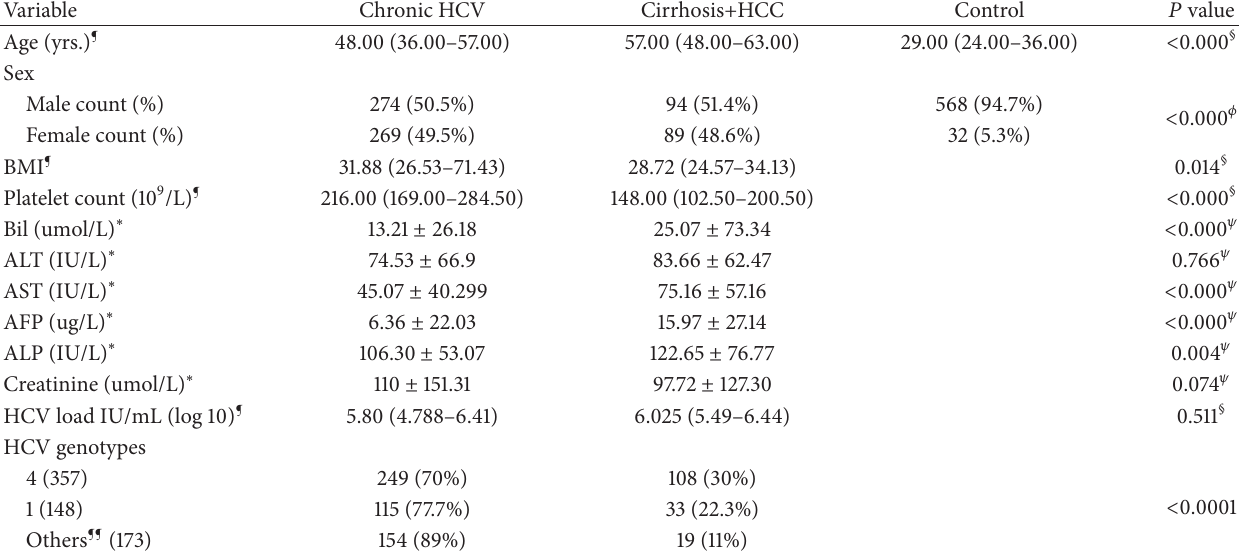
Table 1: Basic characteristics of all subjects included in this